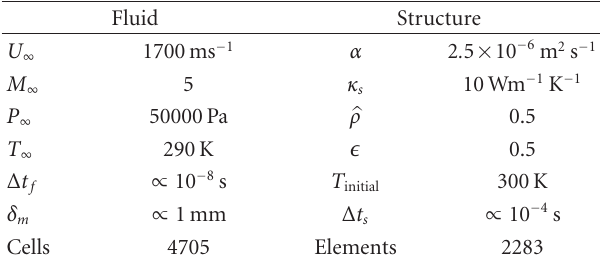
Table 2: Flap simulation parameters. Fluid